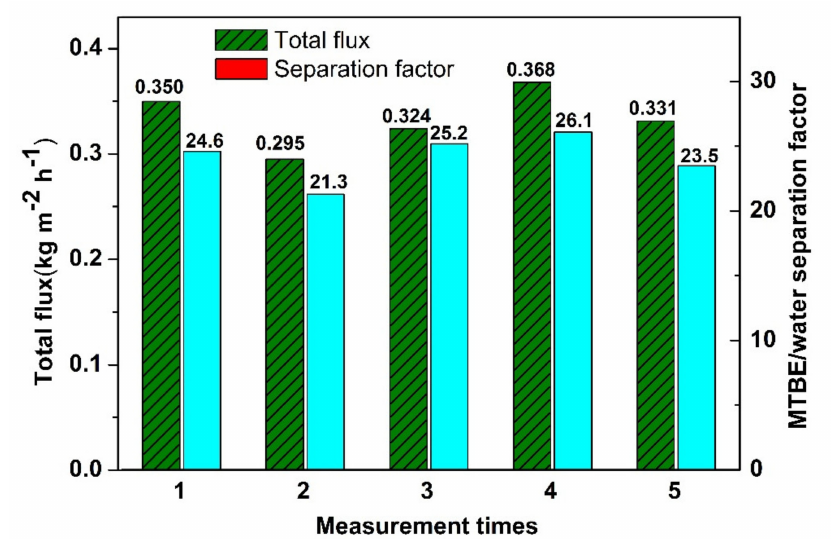
Figure 13. The pervaporation performance of PFOTES-SiO 2 membrane measured at di ff erent times.